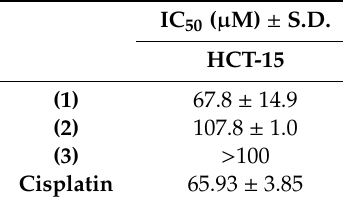
Table 4. Cytotoxicity towards colon cancer cell